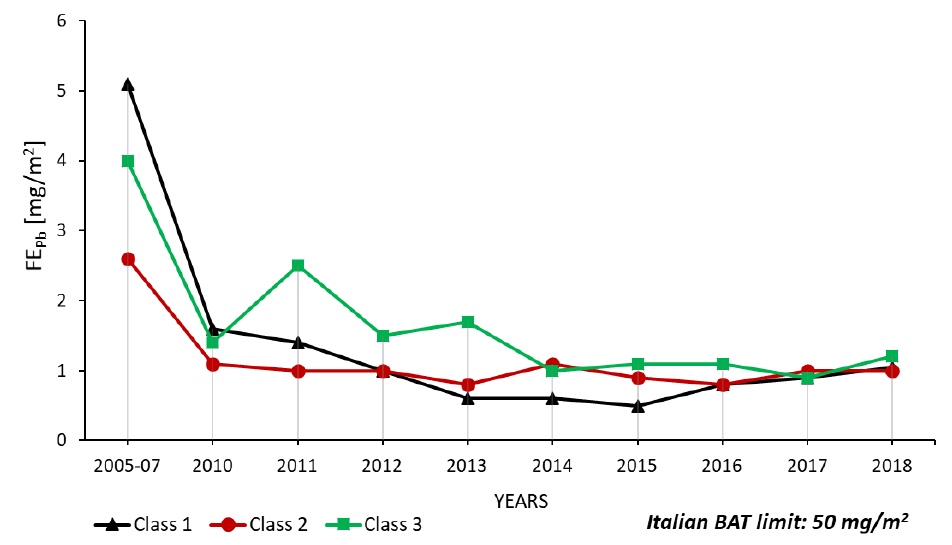
Figure 5. Trend for the emission factor of lead (EF Pb ) for the three production classes.